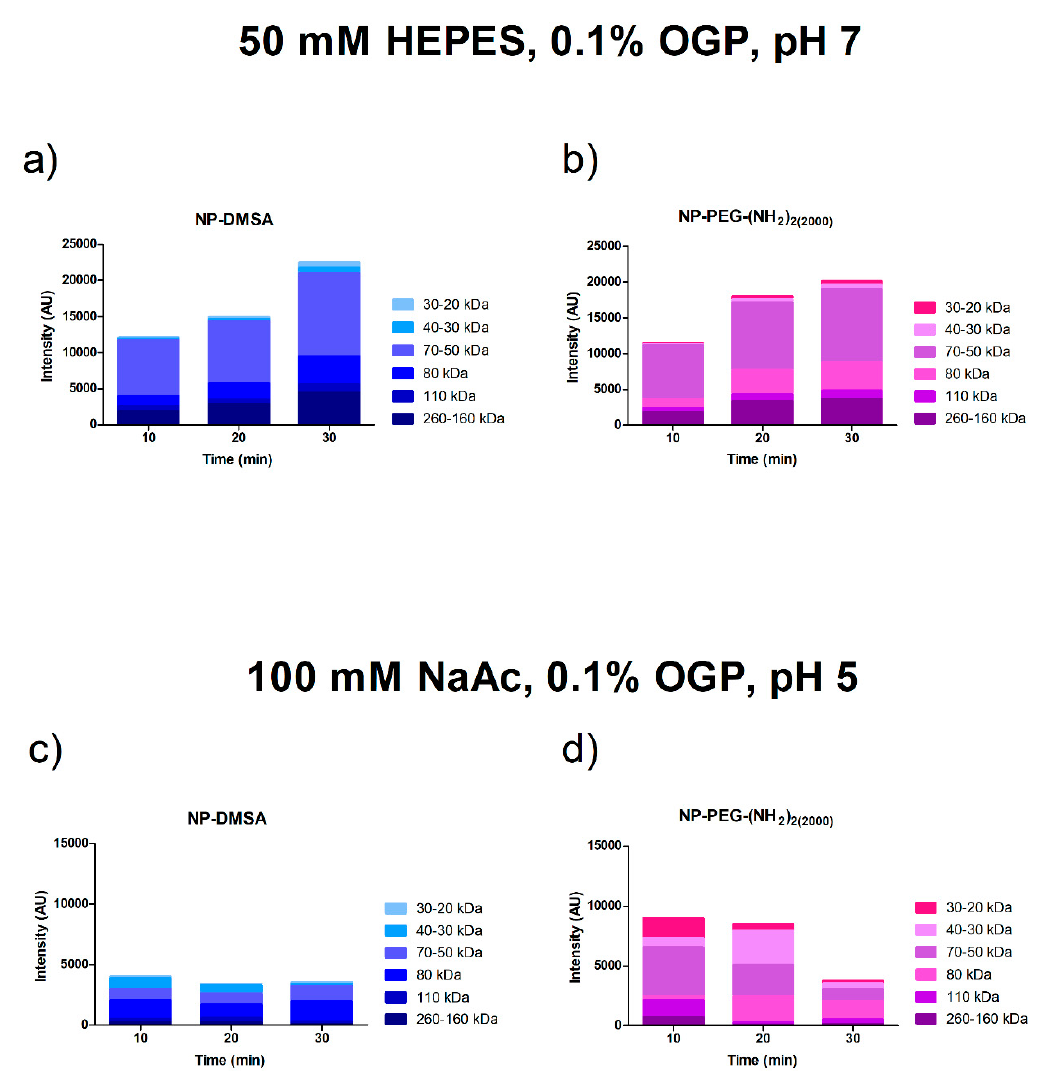
Figure 3. Densitometric analysis of the Coomassie blue-stained SDS-PAGE bands. Proteins from particles incubated at 10, 20 and 30 min at 37 °C were eluted sequentially with buffers at different pH. Top panel: Proteins eluted after incubation in buffer 50 mM HEPES 0.1% OGP, pH 7 (soft corona). Lower panel: Proteins eluted after incubation in buffer 100 mM NaAc 0.1% OGP, pH 5 (hard corona). ( a and c ) NP-DMSA ( b and d ) NP-PEG-(NH 2 ) 2 (2000) .